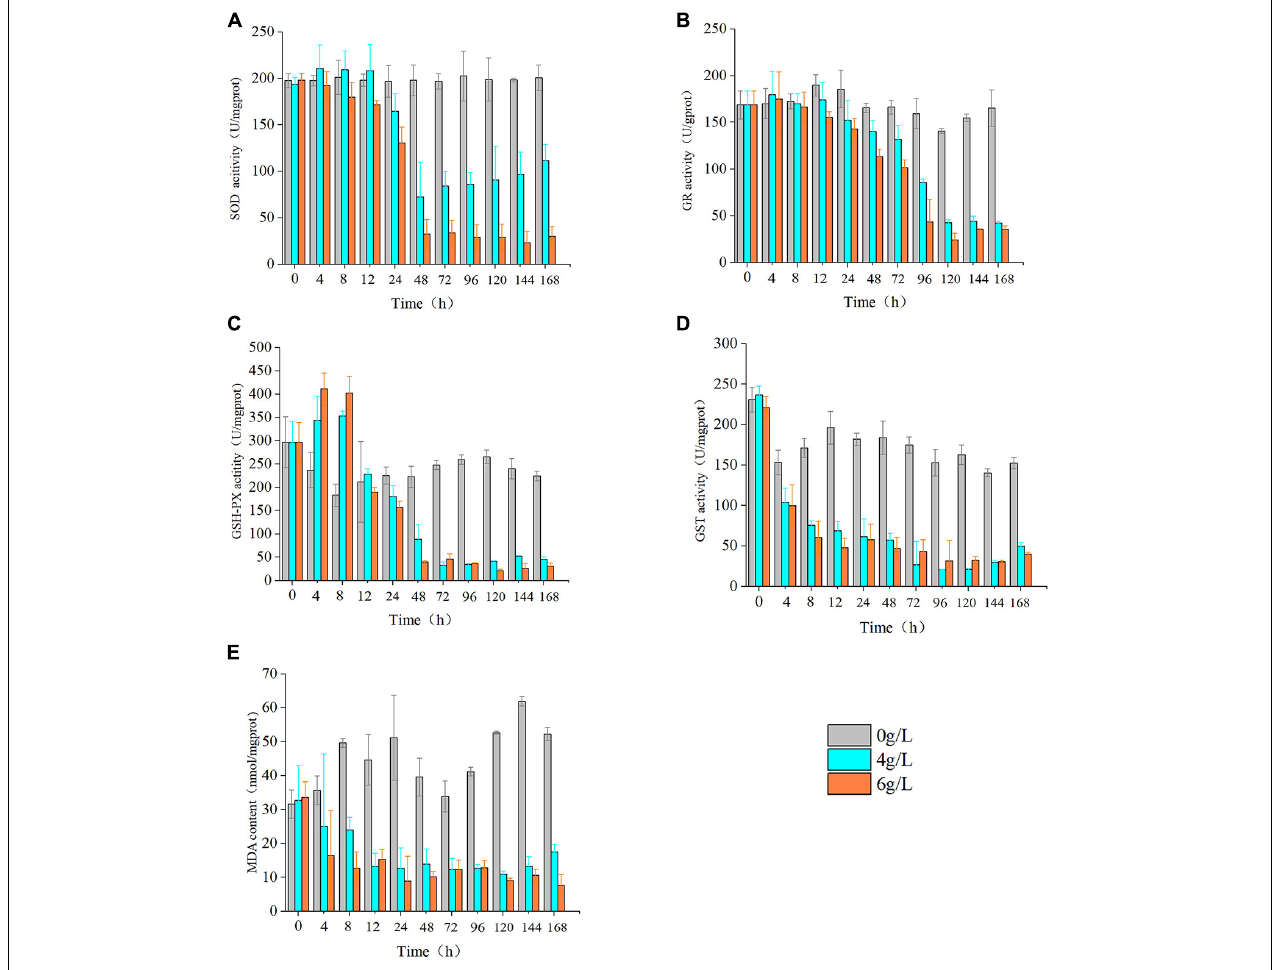
FIGURE 8 | Effect of hijiki extract on the activity of enzymes. (A) SOD, (B) GR, (C) GSH, (D) GST, and non-enzymatic antioxidants (E)